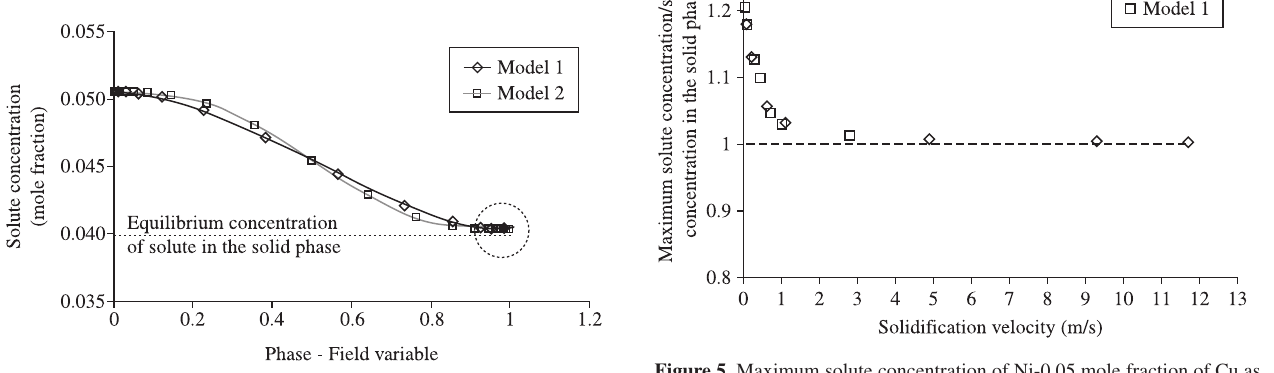
Figure 3. Solute concentration profile of Ni-0.05 mole fraction of Cu alloy along the interface, from solid side (1) to liquid side (0) at very low solidifi- cation velocity (V = 8.0 × 10 –5 m/s): Model 1 means present work based on phase field model from Kim et al. 6 ; Analytical means one-dimensional analytic solution of sharp interface model 6 .